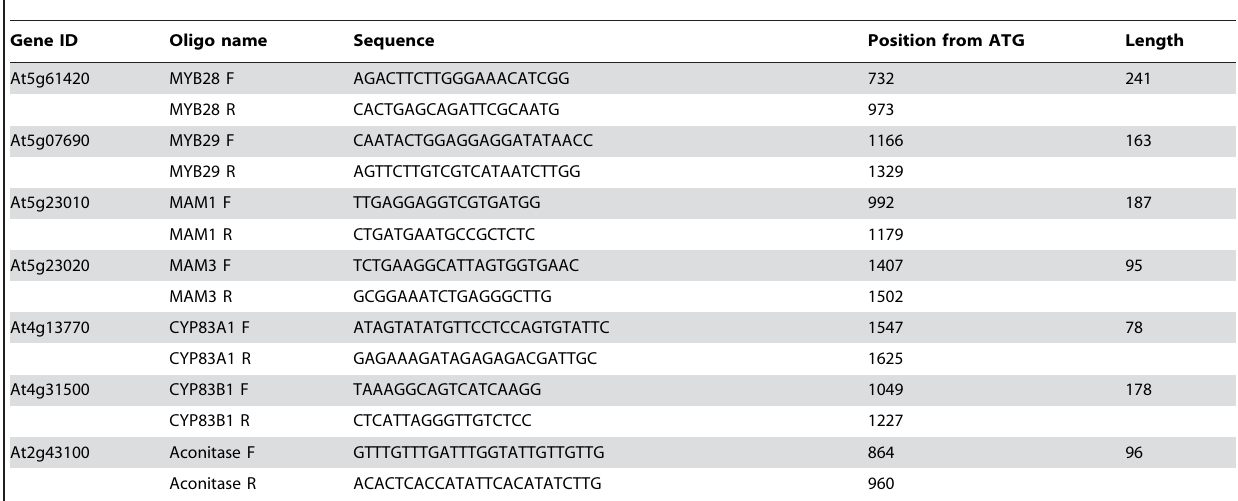
Table 3. Genes and primer pairs used for quantitative RT-PCR